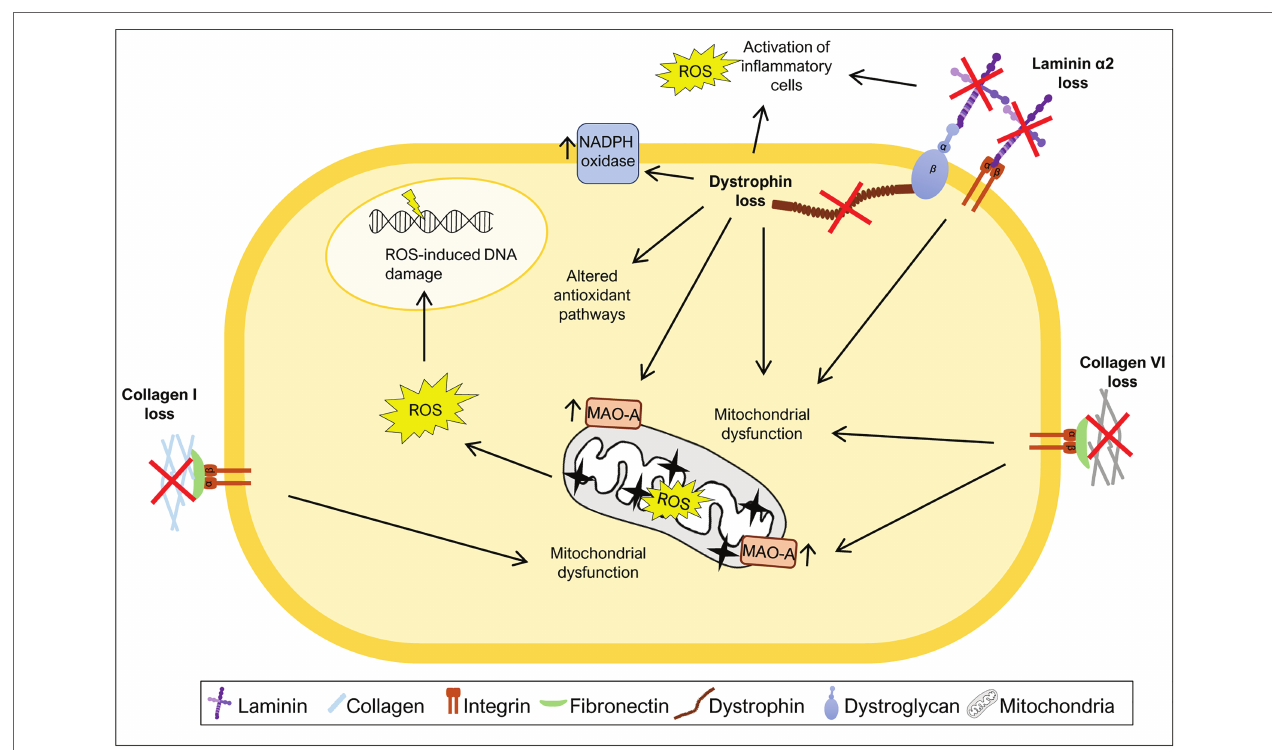
FIGURE 2 | Mutations in ECM components increase oxidative stress. Many diseases caused by mutations in ECM components or components that link ECM to the cytoskeleton have been associated with generation of excess ROS levels. The loss of collagen I, collagen VI, laminin α 2, or dystrophin was shown to